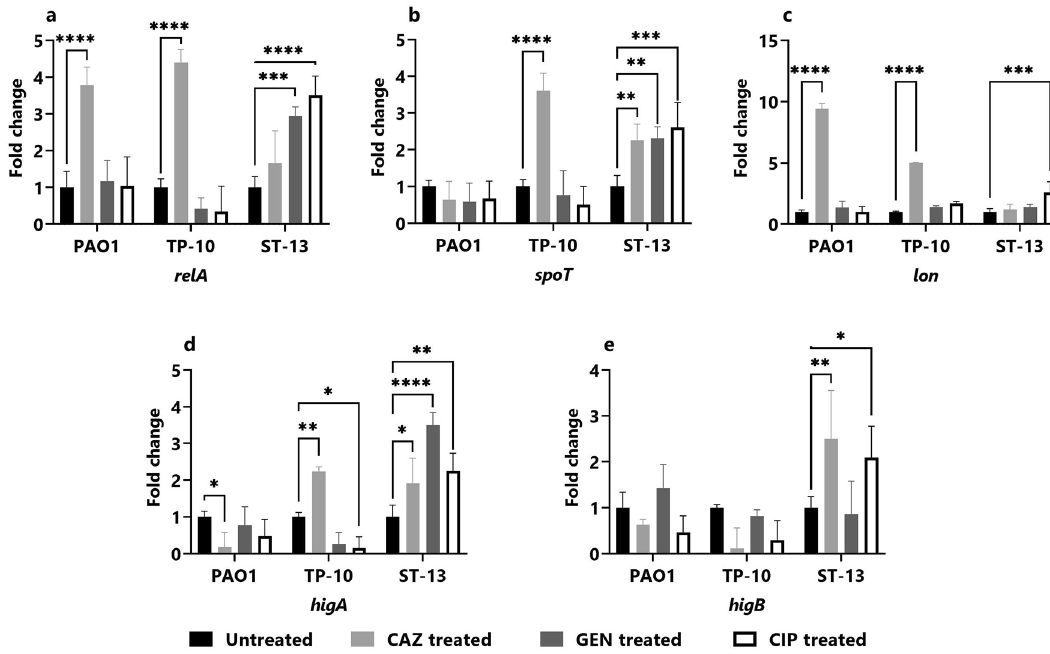
Figure 8. Gene expression studies in the biofilm stage. The gene expression of stringent response genes: ( a ) relA , ( b ) spoT , and ( c ) lon as well as toxin–antitoxin genes; ( d ) higA and ( e ) higB was studied in PA01, TP-10, and ST-13 biofilms after 4 h of antibiotic (CAZ, GEN, and CIP) treatment. Prior to it, the biofilm was formed for 24 h in six well plates. The gene expression was normalized to the untreated control. CAZ: ceftazidime, GEN: gentamicin, CIP: ciprofloxacin. The three biological experiments were performed for each strain. The corresponding data represents the mean ± standard deviation of fold change. The statistical analysis was performed using the two-way ANOVA, which was * P < 0.05, ** P < 0.01, *** P < 0.001, and **** P < of stringent response genes, toxin-antitoxin systems, quorum sensing, and SOS response 13 . Many studies have documented PC formation upon antibiotic exposure with respect to the type strains of P. aeruginosa; PAO1 and PA14 14,17,20 . The present study highlights the PC formation in response to exposure of three antibiotics belonging to different classes: ceftazidime, gentamicin, and ciprofloxacin in PAO1, TP-10, and ST-13 strains under two physiological conditions (planktonic and biofilm stage). The effect of three antibiotics that lead to PC formation